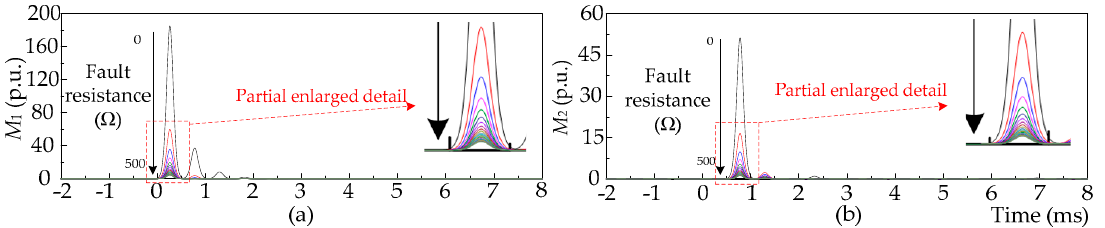
Figure 10. The curves of M 1 and M 2 during the PG faults 50 km from the rectifier-terminal under different fault resistance conditions. ( a ) Curves of M 1 . ( b ) Curves of M 2 . Table 1. Fault-location results for various PG